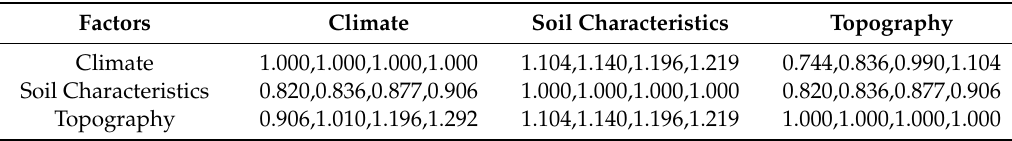
Table 6. Trapezoidal fuzzy number pairwise comparison matrix for the main